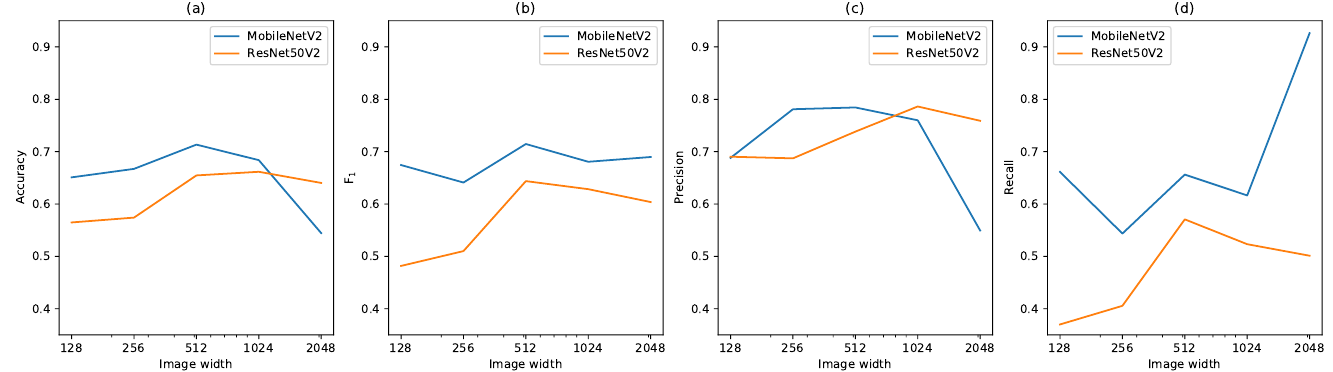
Figure 9. Accuracy ( a ), F 1 score ( b ), precision ( c ) and recall ( d ) of IAPS on the validation set for MobileNetV2 and ResNet50V2 as a function of image size. All invasive species are grouped together, and misclassifications between them are ignored.